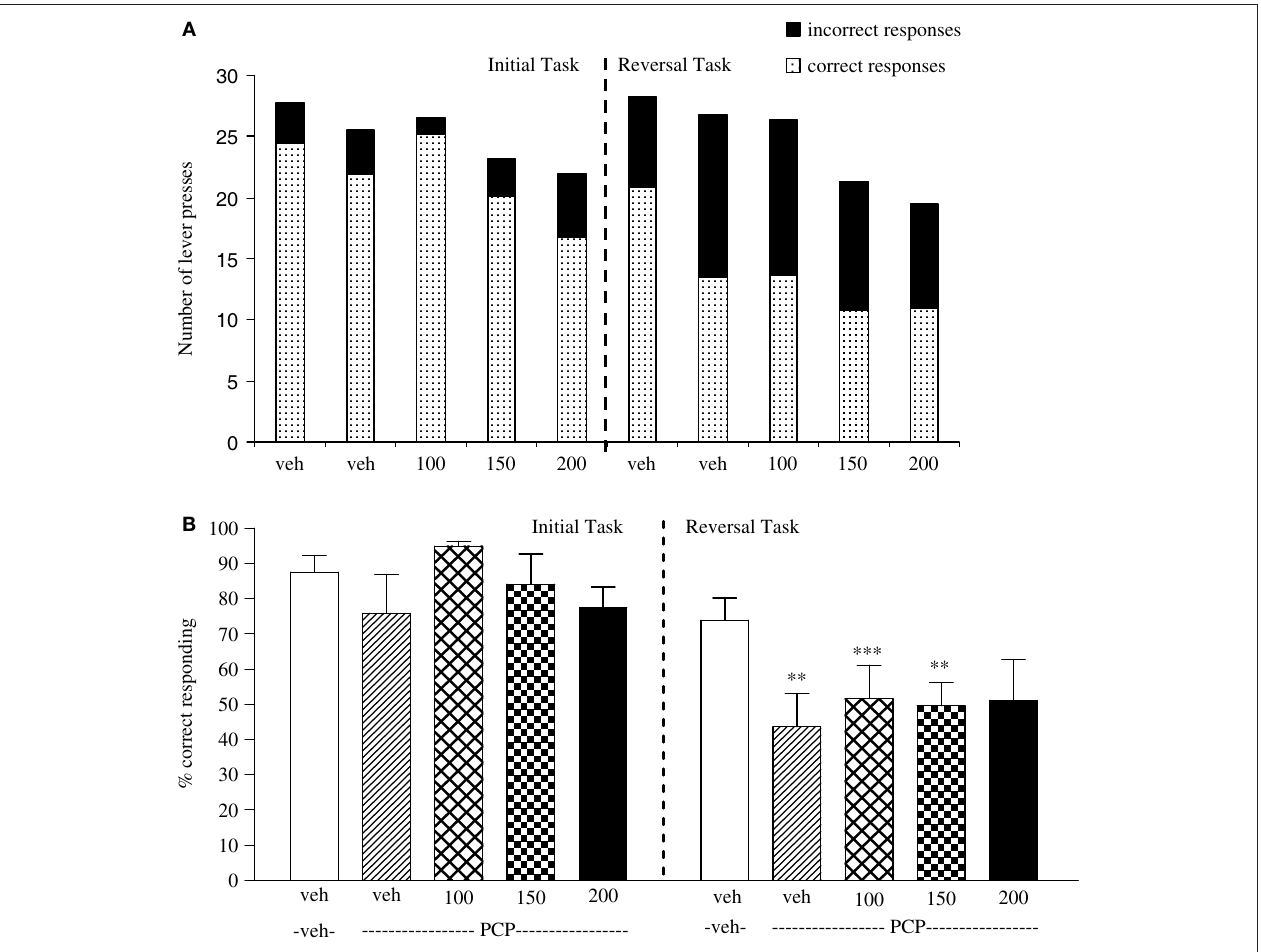
valproate pretreatment (100–200 mg/kg, i.p.) on the defi cit produced by PCP (1.5 mg/kg, i.p.) on performance of the reversal phase in a reversal learning task. Data are shown as mean ± S.E.M. percentage correct responding ( n = 8 per group). Signifi cant reduction in performance of the reversal phase compared